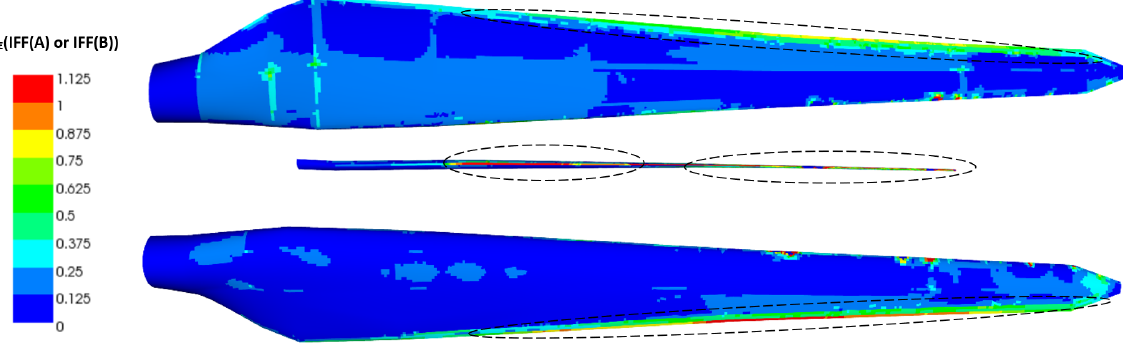
Figure 18. Damage evolution – IFF (A) or IFF (B) – in the pressure side, internal flange and suction side of the blade (from top to bottom in a panel) at 50% of extreme flapwise loading.